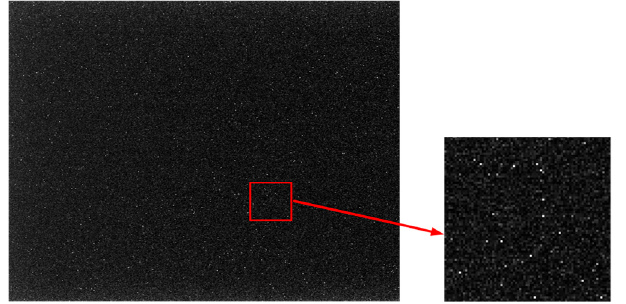
Figure 2. The noise caused by a nonuniform response of a CMOS detector.